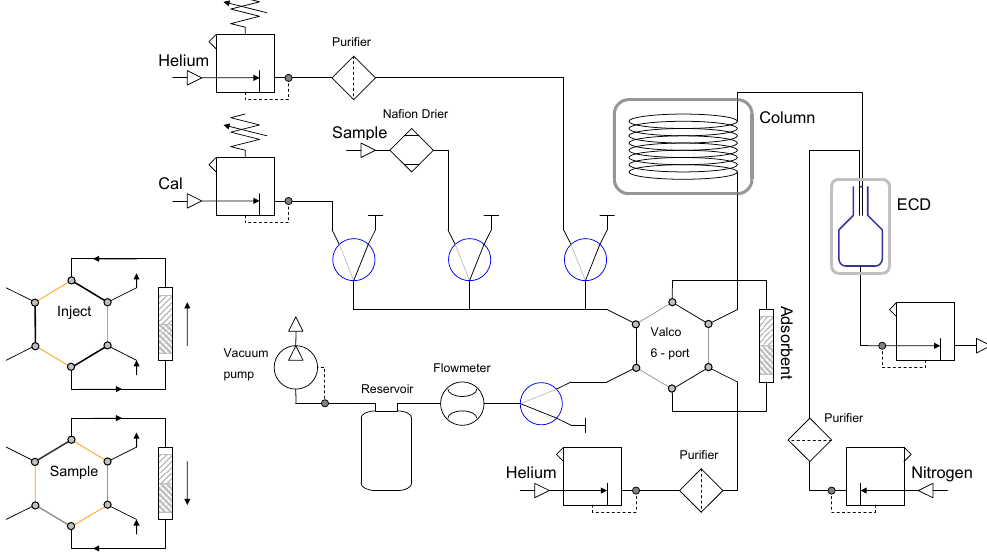
Fig. 1. Schematic of the core µ Dirac gas chromatograph. The smaller schematics in the lower left show the Valco valve flow paths for the “inject” and “sample”